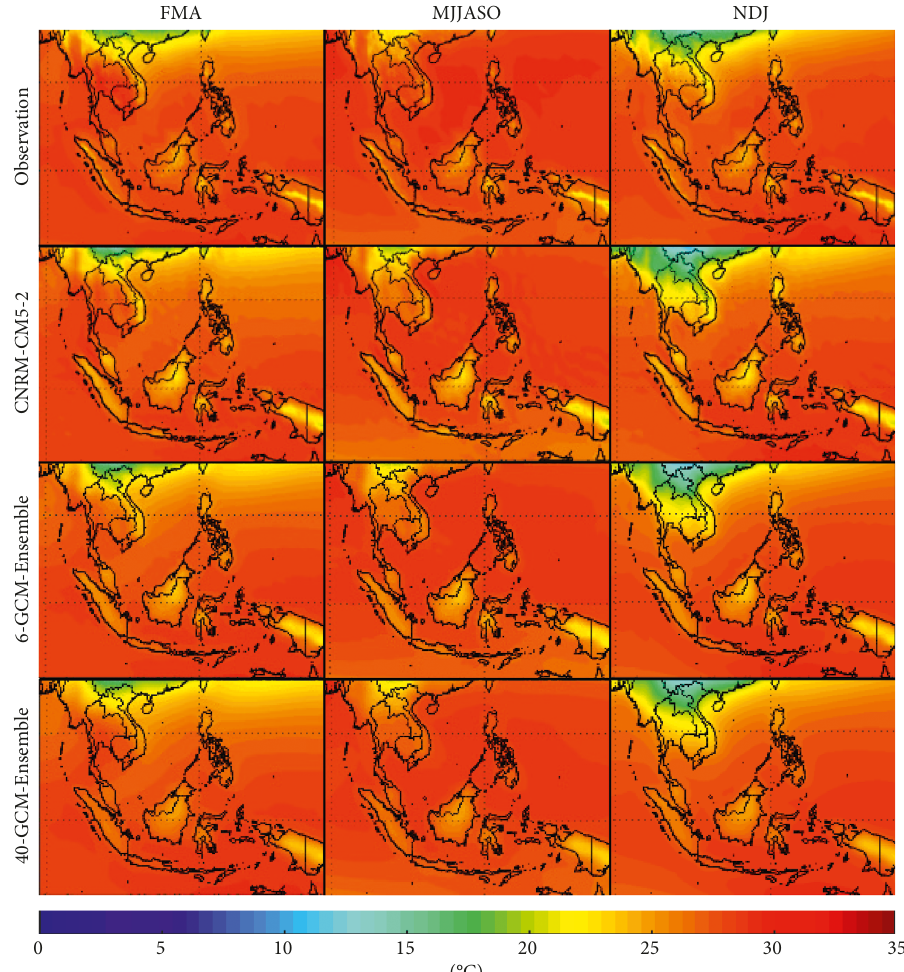
Figure 8: Comparisons of average seasonal temperatures ( ° C) for years 1960–1999 of observations, CNRM-CM5-2, 6-GCM-Ensemble, and 40-GCM-Ensemble, from top to bottom rows, respectively. Columns from left to right show hot (FMA), rainy (MJJASO), and cold (NDJ) seasons,